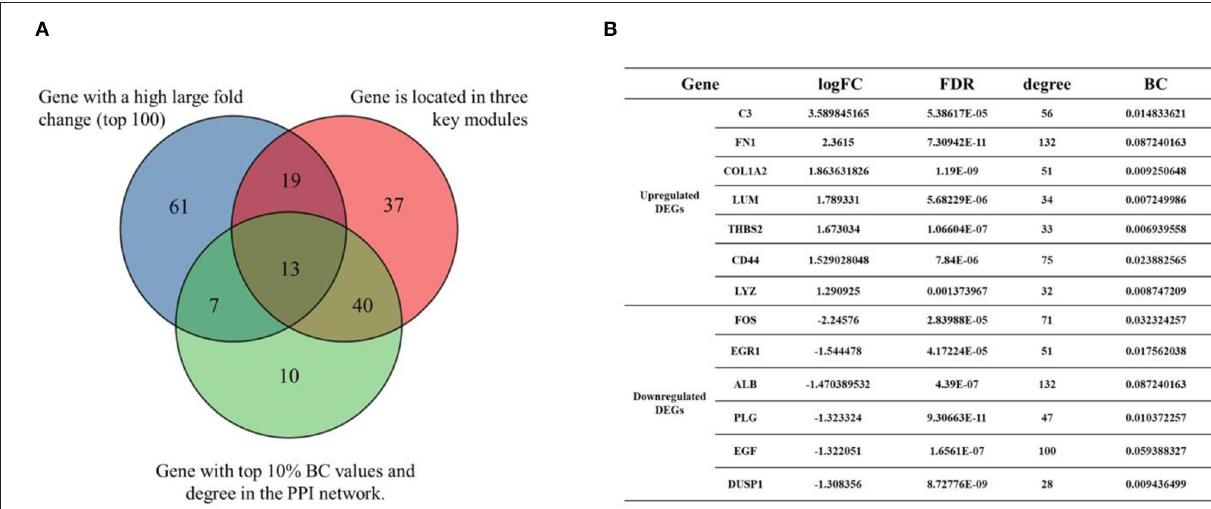
FIGURE 5 | Venn diagram of core genes. (A) The blue circle represents DEGs that had a high large fold change (top 100). The red circle represents DEGs that were located in the three key modules. The green circle represents DEGs that had the top 10% BC values and degree in the PPI network. (B) Details of core genes (FC, FDR adjusted p -value, node degree, node BC value).